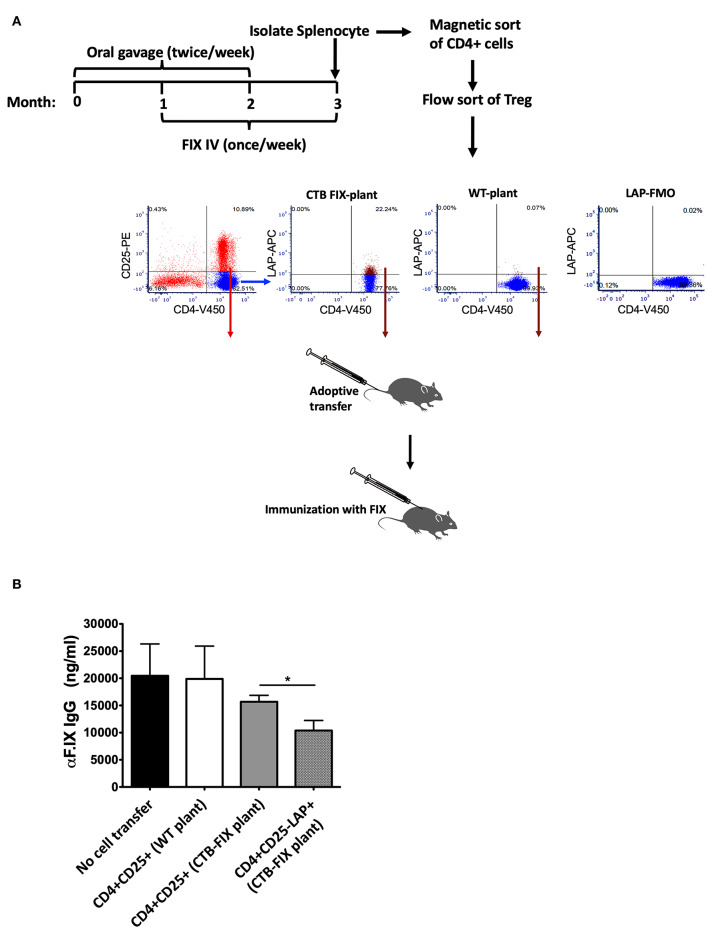
Suppression of antibody formation against FIX after adoptive transfer of Treg. (A) Experimental outline of oral tolerance with bioencapsulated CTB-FIX/intravenous treatment with FIX, T cell isolation, adoptive transfer, and immunization. Donor hemophilia B mice had been treated in this manner or were naïve control mice. Flow cytometry plots show results from purification of splenic CD4+CD25+ T cells and CD4+CD25−LAP+ T cells by flow sorting. (B) FIX-specific IgG titers in mice that received either CD4+CD25+ T cells or CD4+CD25−LAP+ T cells after immunization with FIX. Results are average ±SD (n = 5/group). * indicates P < 0.05.